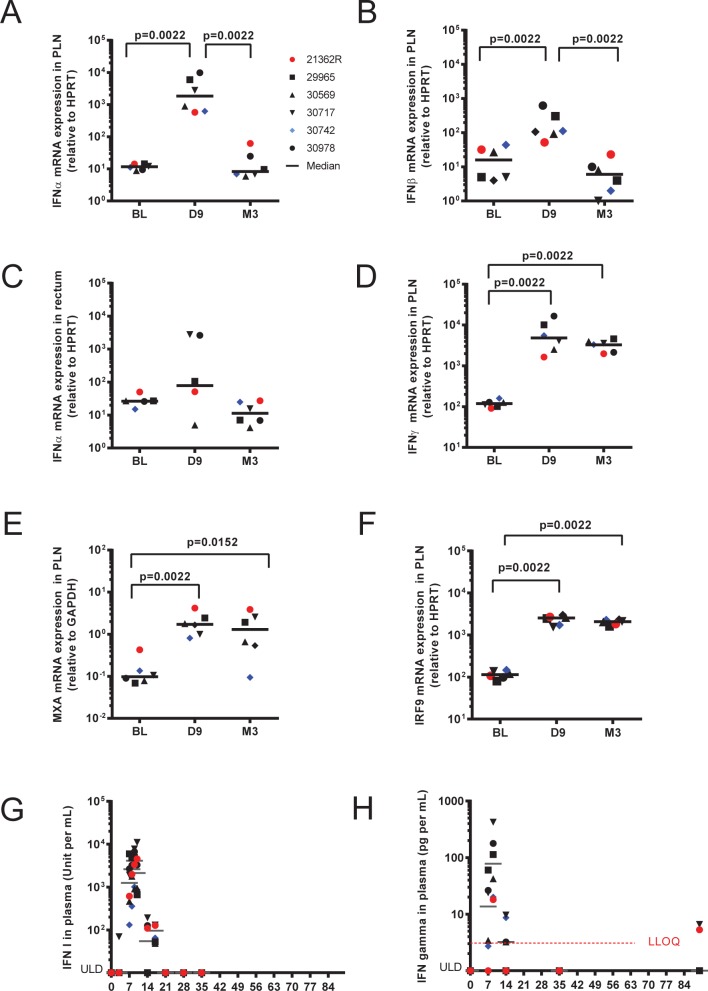
Confirmation of differential expression of IFNs in tissues by RT-qPCR and at the protein level in plasma.(A) IFN-α mRNA expression in PLNs by RT-qPCR. (B) IFN-β mRNA expression in PLNs by RTqPCR. (C) IFN-α mRNA expression in RB by RT-qPCR. (D) IFN-γmRNA expression in PLNs by RT-qPCR. (E) MXA mRNA expression in PLNs by RT-qPCR. (F) IRF9 mRNA expression in PLNs by RT-qPCR. (G) Type-I IFN antiviral activity measured in plasma (MDBK/VSV biological assay) and (H) plasma IFN-γ concentration (measured by Luminex). ULD = Under the Limit of Detection. The Lower Limit of Quantification (LLOQ) is represented as a red dotted line in figure 3H. P values are given for non-parametric Wilcoxon rank sum test and was considered significant if p < 0.05.